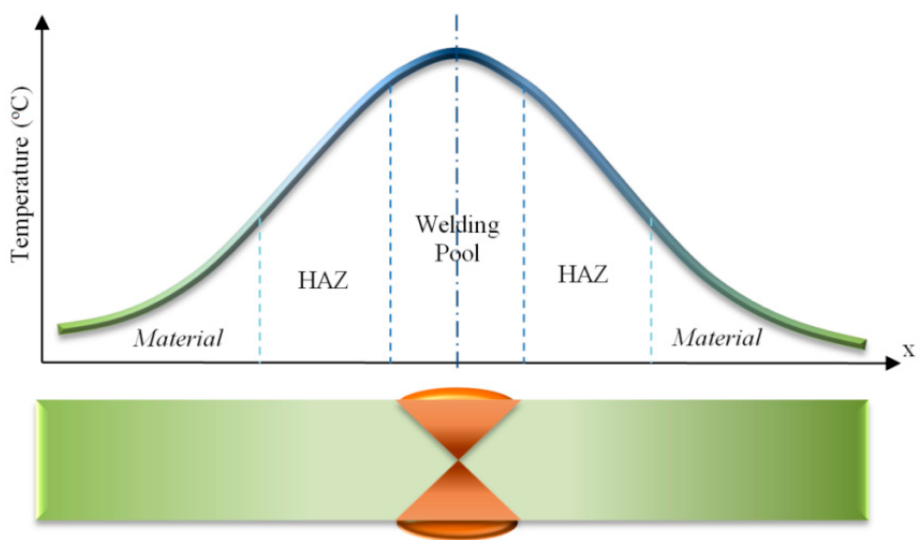
Figure 13. Heat affected zone properties. Figure 13. Heat a ff ected zone